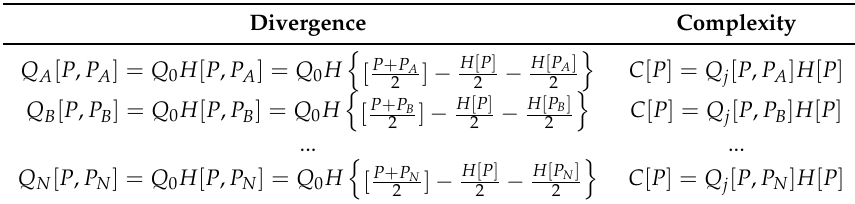
Table 1. Calculation of the divergence based on N